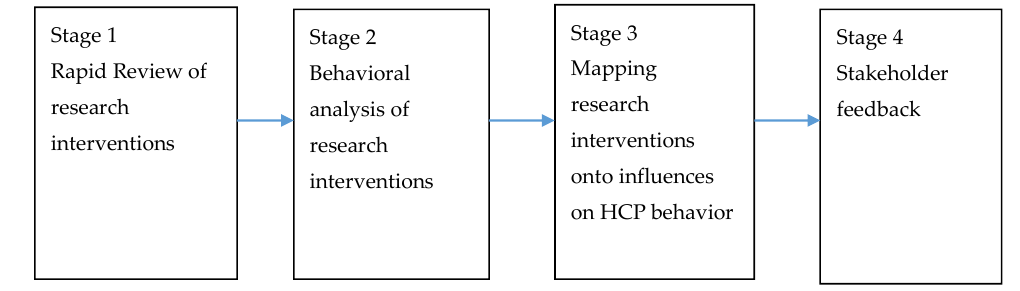
Figure 1. Overview of the study components.